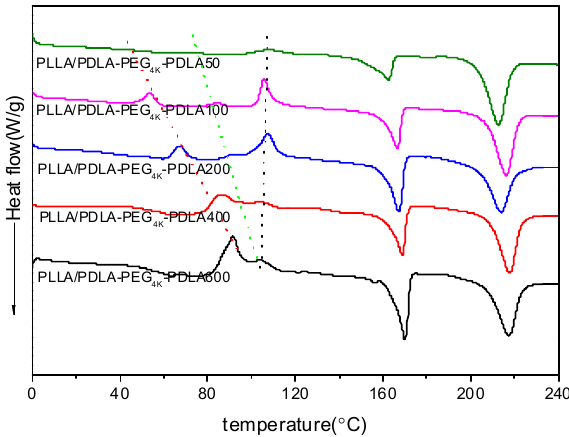
Figure 7. DSC heating curves of PLLA/PDLA-PEG 4k -PDLA blends with different PDLA blocks after quenching from 240 °C.